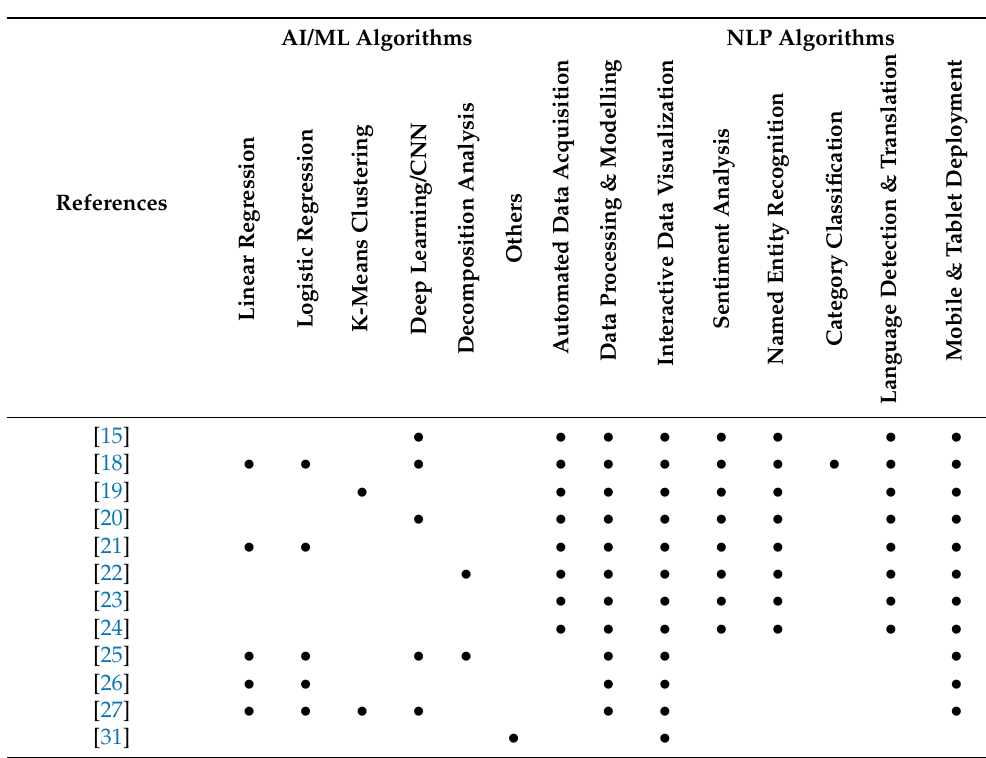
Table 3. Features of LCNC platforms used in solving research